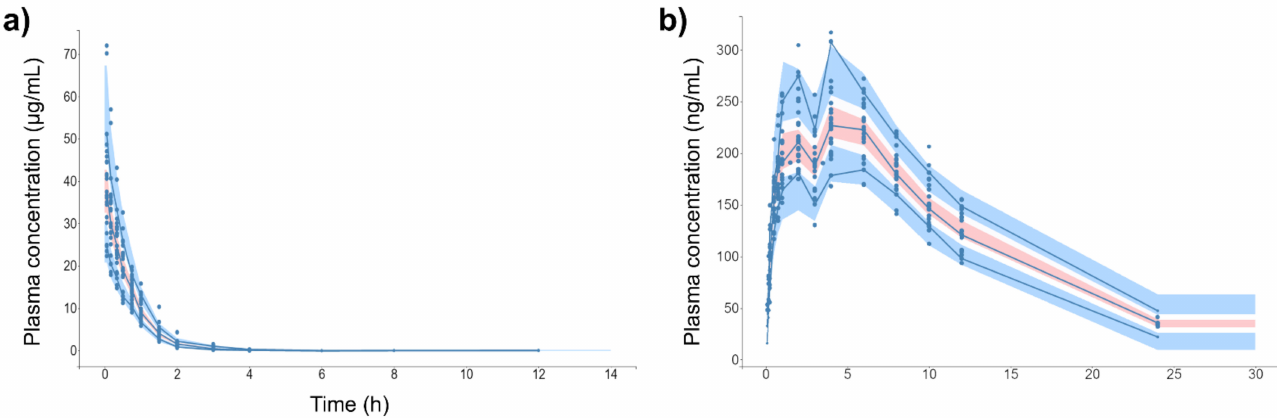
Figure 6. Visual predictive check (VPC) plot of final popPK models. ( a ) Intravenous rutin. ( b ) Quercetin from oral rutin. Blue dots are the observations ( n = 25). Solid blue lines are the empirical 90th percentile. Blue and red shaded areas represent the 90% prediction interval based on 1000 simulated data. Quercetin represents the conjugates quercetin-3- O -glucuronide and quercetin-3- O